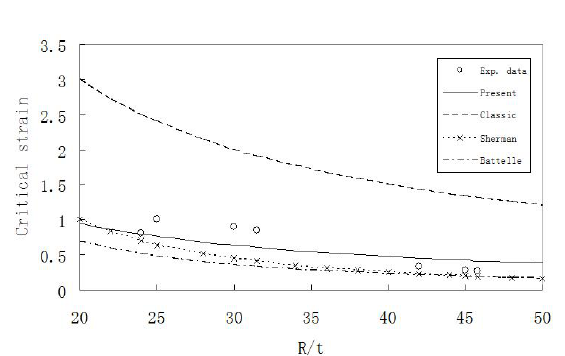
Figure 5. Comparison of the experimental data with different